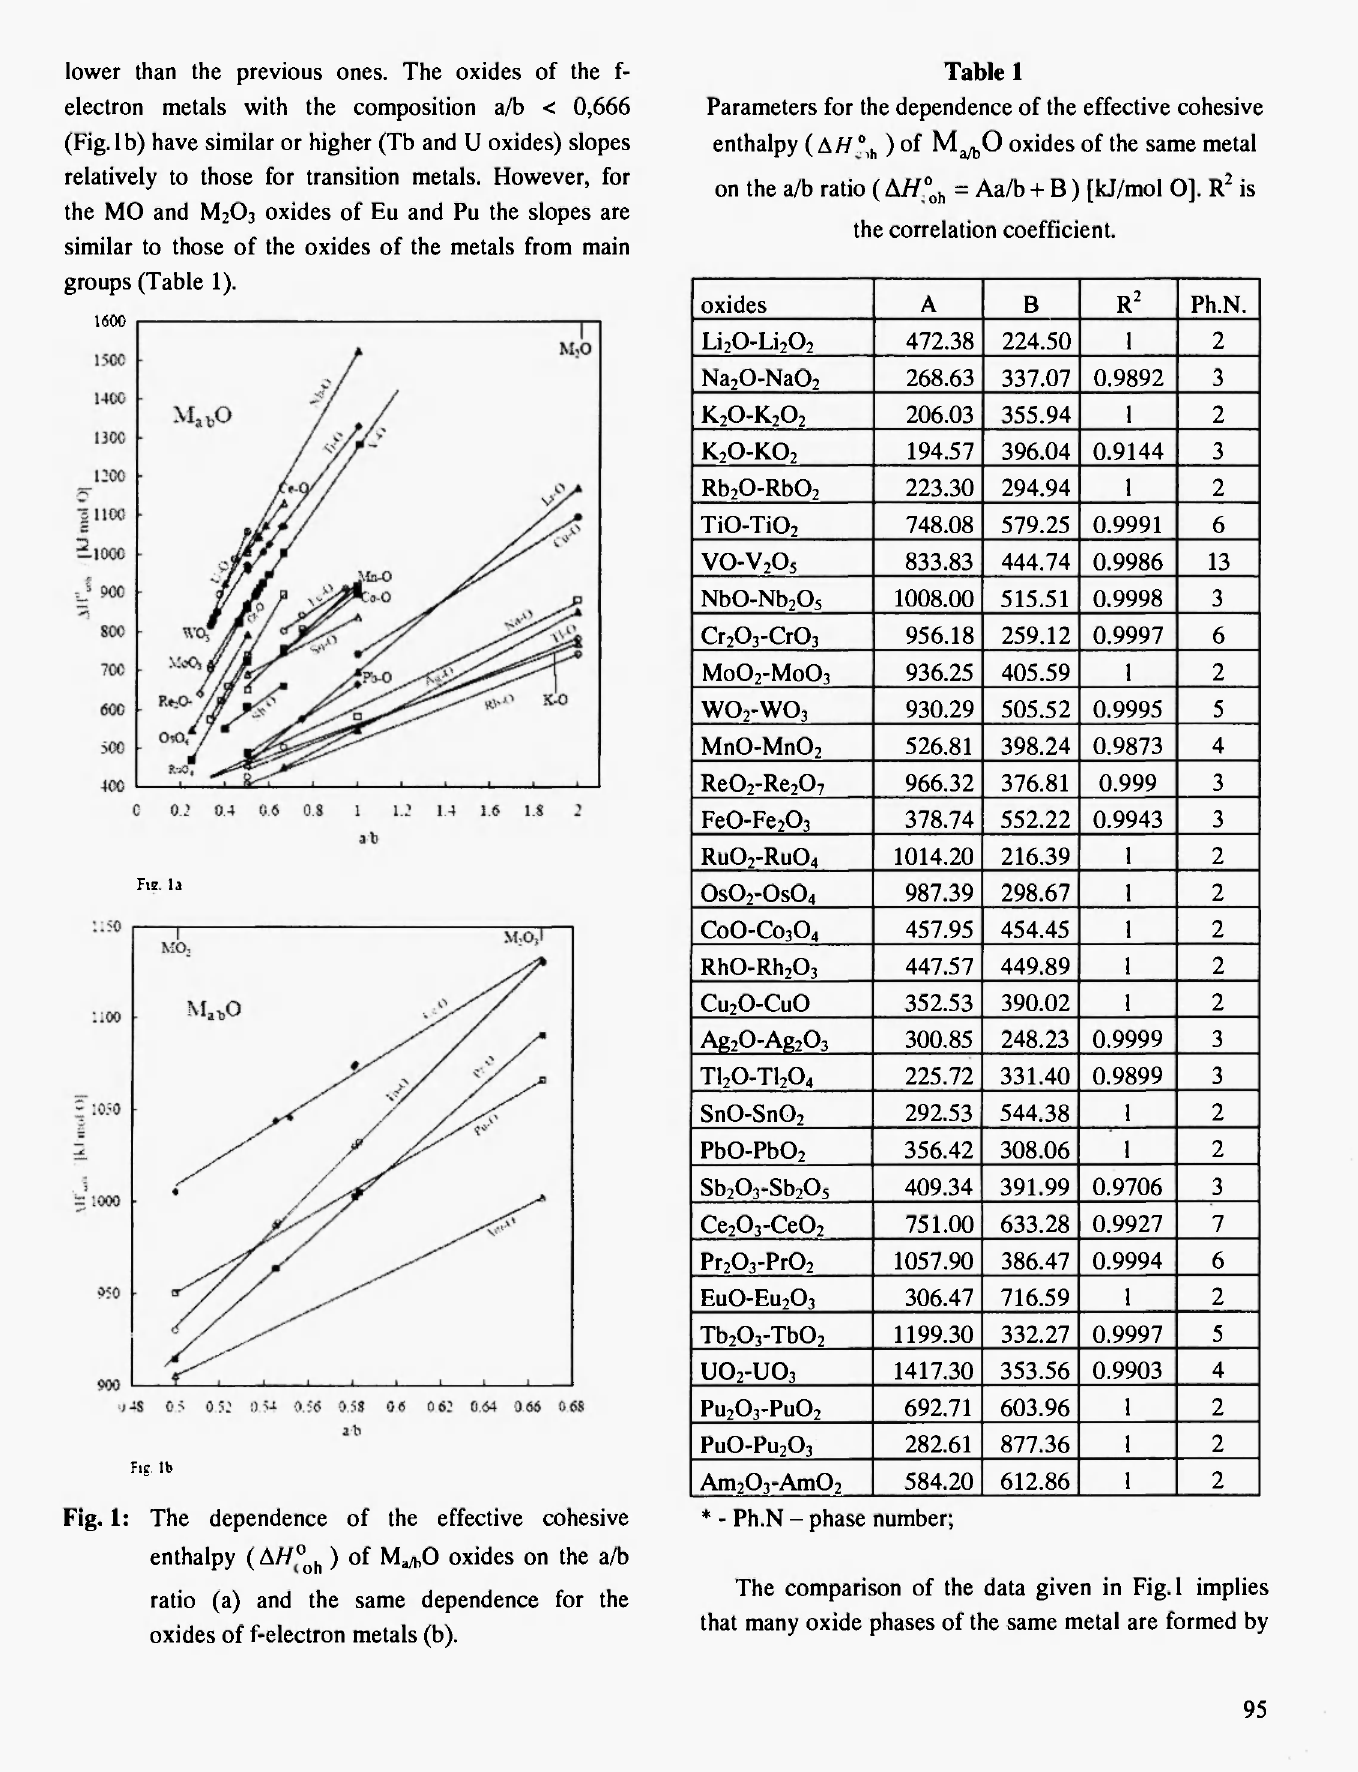
Parameters for the dependence of the effective